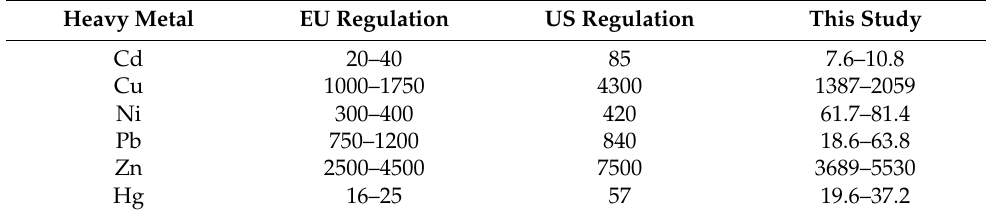
Table 5. The allowable limits of HMs [mg/kg] in the EU and US